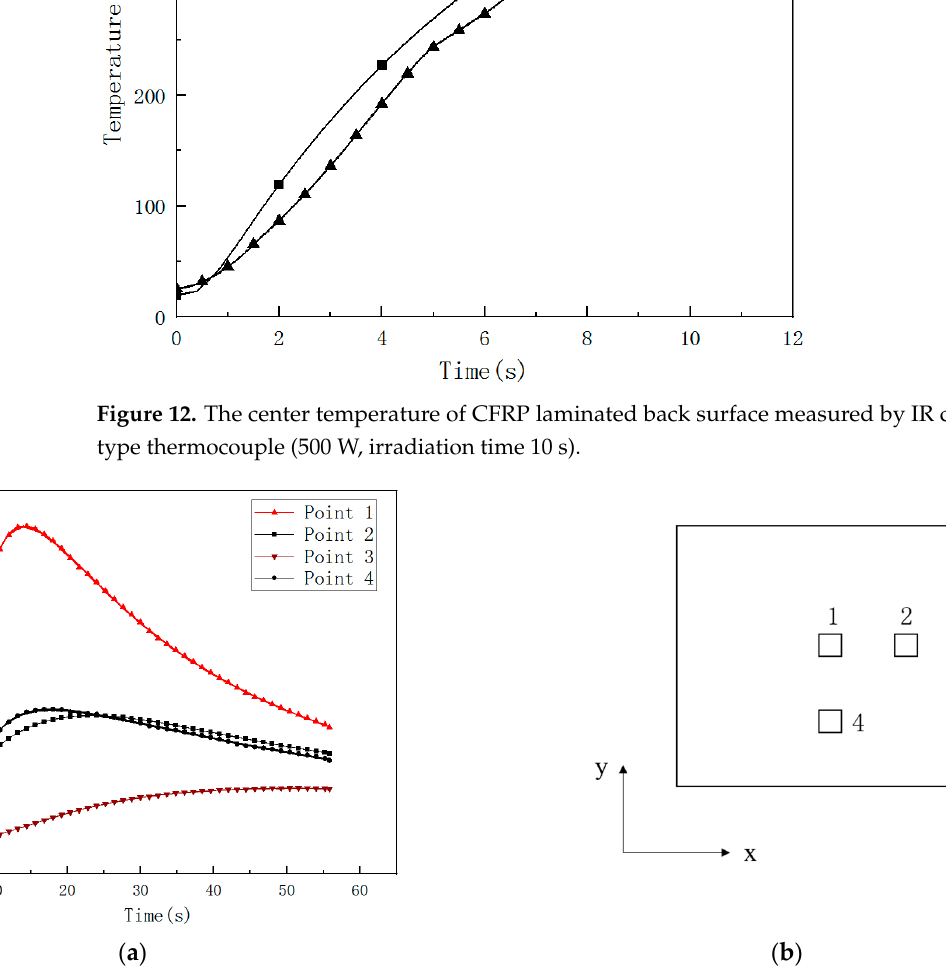
Figure 13. The temperature curves at different points on the CFRP laminated back surface measured by K type thermocouple (500 W, irradiation time 5 s). ( a ) The temperature curves at different points; ( b ) temperature measuring points on the back surface.